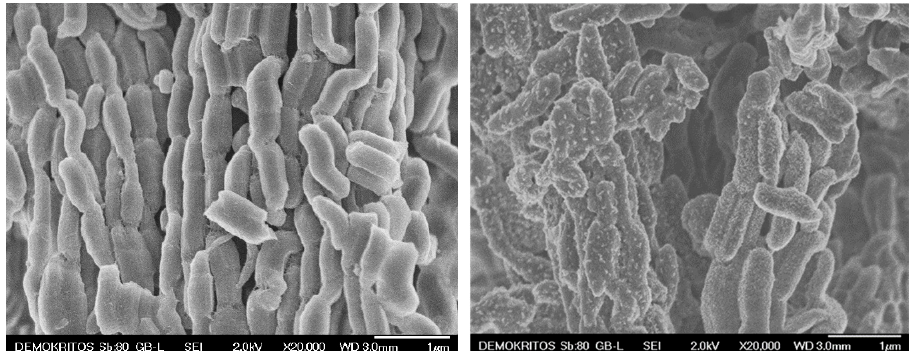
Figure 2. Scanning electron microscope (SEM) pictures showing the typical elongated structure of of pure CMK-3 ( left ) and LiNa/CMK-3 after melt infiltration, with traces of borohydrides on the pure CMK-3 ( left ) and LiNa/CMK-3 after melt in fi ltration, with traces of borohydrides on the external surface of the carbon particles ( right external surface of the carbon particles ( right ).